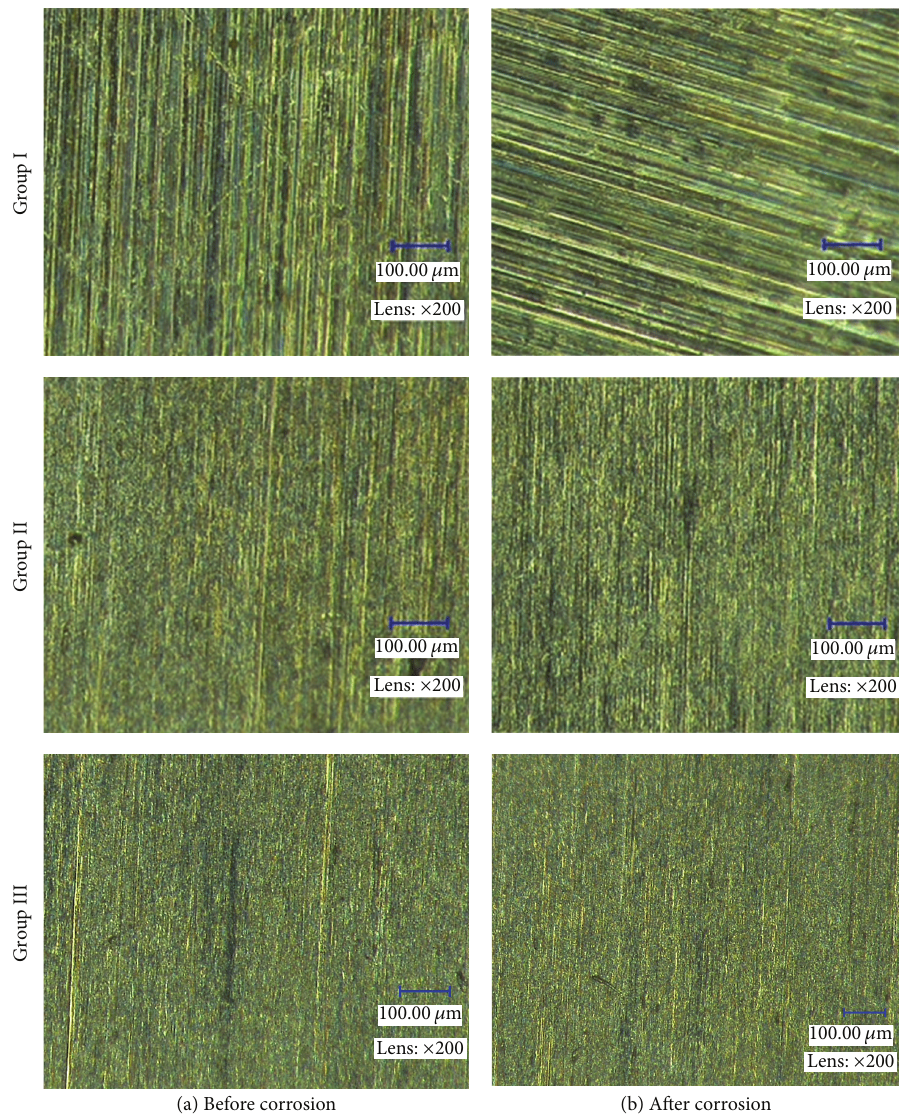
Figure 6: Images of turning sample under different gas conditions before and after surface